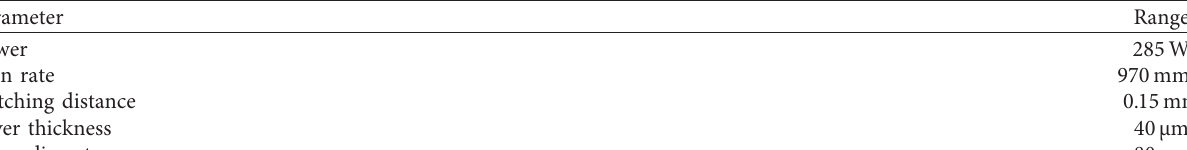
Table 2: Parameter for manufacturing IN718 samples in DMLS machine.